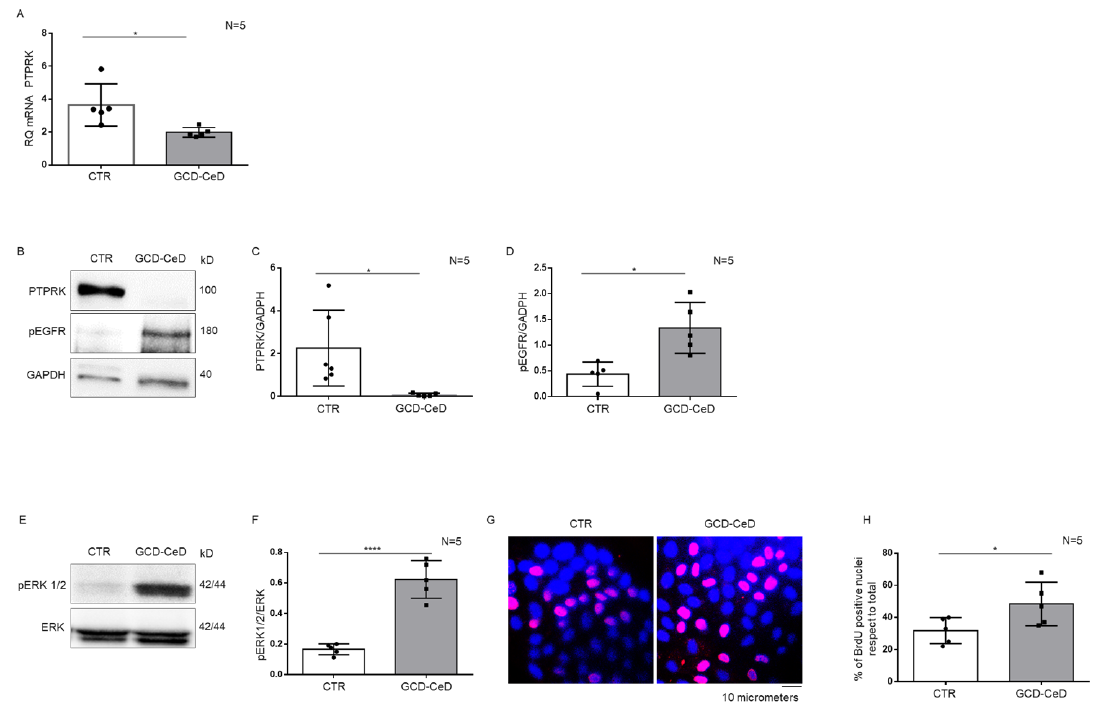
Figure 3. CeD organoids have low levels of PTPRK mRNA, and protein, pEGFR, pERK and proliferation are increased . ( A ). PTPRK mRNA levels in CTR and GCD–CeD organoids analysed by Real Time PCR. Columns represent the mean and bars the standard deviation. Student’s t test: * = p < 0.05. ( B ). Western blot analysis of total protein lysates of intestinal organoids from CTR and GCD–CeD. The membrane was blotted with antibodies against PTPRK, pEGFR and GAPDH as loading control. ( C , D ).Densitometric analysis of the PTPRK/GAPDH and pERK/GAPDH bands. Columns represent the mean and bars the standard deviation. Student’s t test: * = p < 0.05. ( E ). Upper lines were blotted with an antibody against pERK. Bottom lines were blotted with anti-ERK antibodies as loading control. ( F ). Densitometric analysis of the pERK/ERK bands. Columns represent the mean and bars the standard deviation. Student’s t test: **** = p < 0.0001. ( G ). Immunofluorescence images of anti-BrdU staining on intestinal organoids from CTR and GCD–CeD patients. Red nuclei are positive for BrdU staining. ( H ). Statistical analysis of the percentage of BrdU positive nuclei in intestinal organoids from CTR and GCD–CeD. Columns represent the mean and bars the standard deviation. Student’s t test: * = p < 0.05.